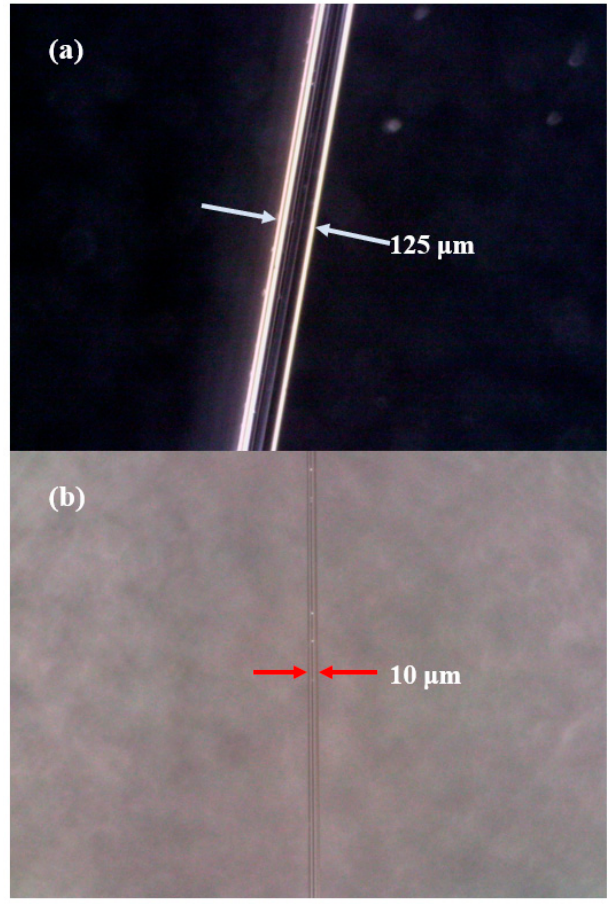
Figure 2. ( a ) Micrograph of single-mode optical fiber; ( b ) micrograph of MFC structure after